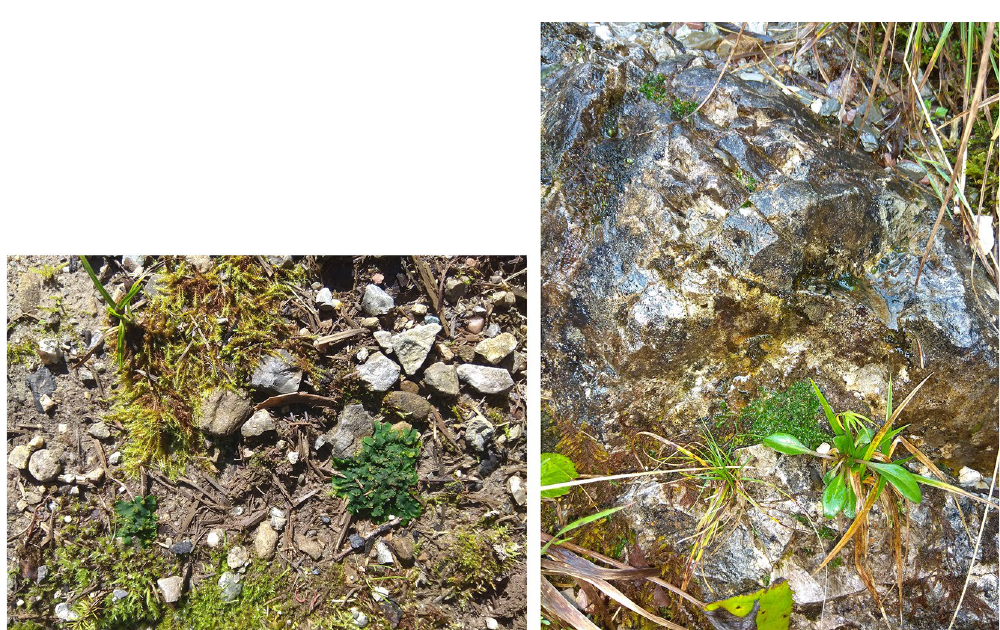
Figure 2. Mixed preferential ecosystems of A. pinguis cryptic species A. More soil material over rocky (left) as compared to more rocky over soil material